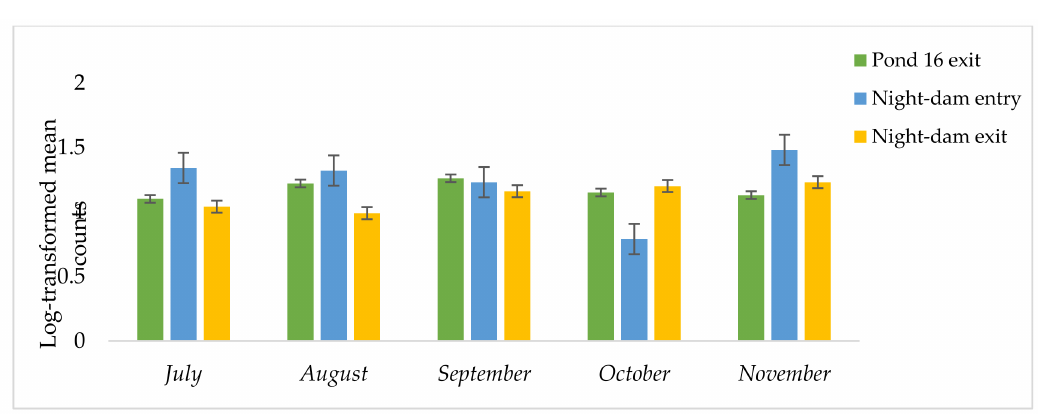
Figure 5. Log transformed Ascaris lumbricoides counts as distributed along the wastewater treatment pathway from Pond 16 exit to night-dam exit for five months in